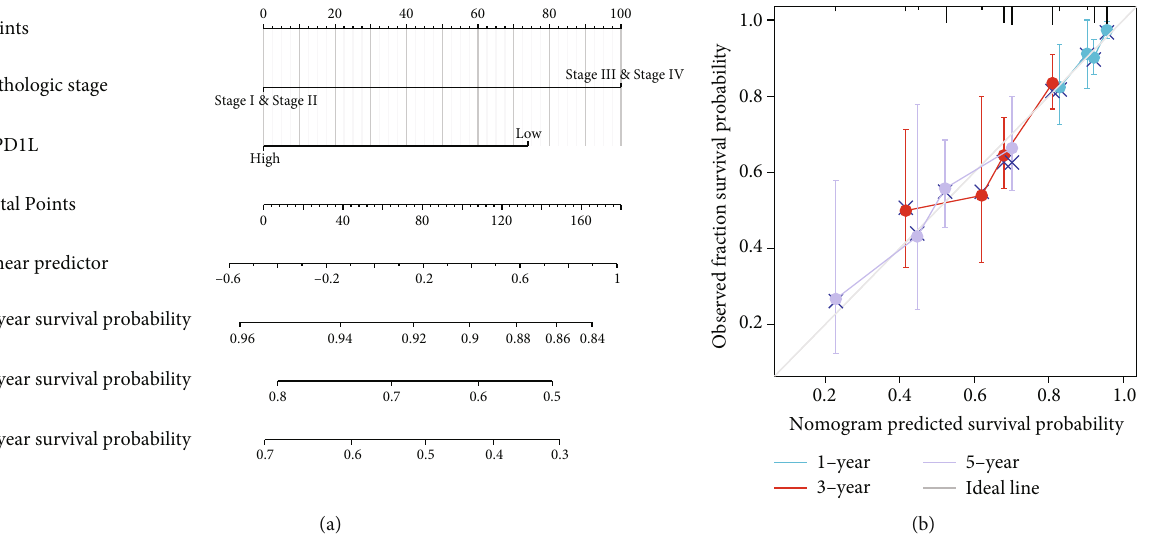
Figure 6: A quantitative method for estimating the likelihood that LUAD patients would develop the illness at 1, 3, and 5 years. (a) A nomogram that estimates the chance of disease-speci fi c survival for LUAD patients at 1, 3, and 5 years. (b) Calibration plots of the nomogram used to assess the overall likelihood of survival at 1, 3, and 5 years.